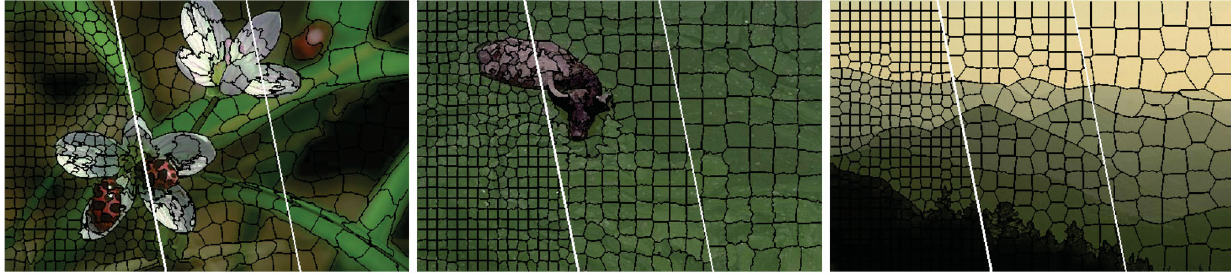
Fig. 11 Images from the Pascal Context dataset segmented by our approach with m = 20 and the number of superpixels set to 1000, 400, and 200, respectively. The resulting superpixels follow region boundaries very well.